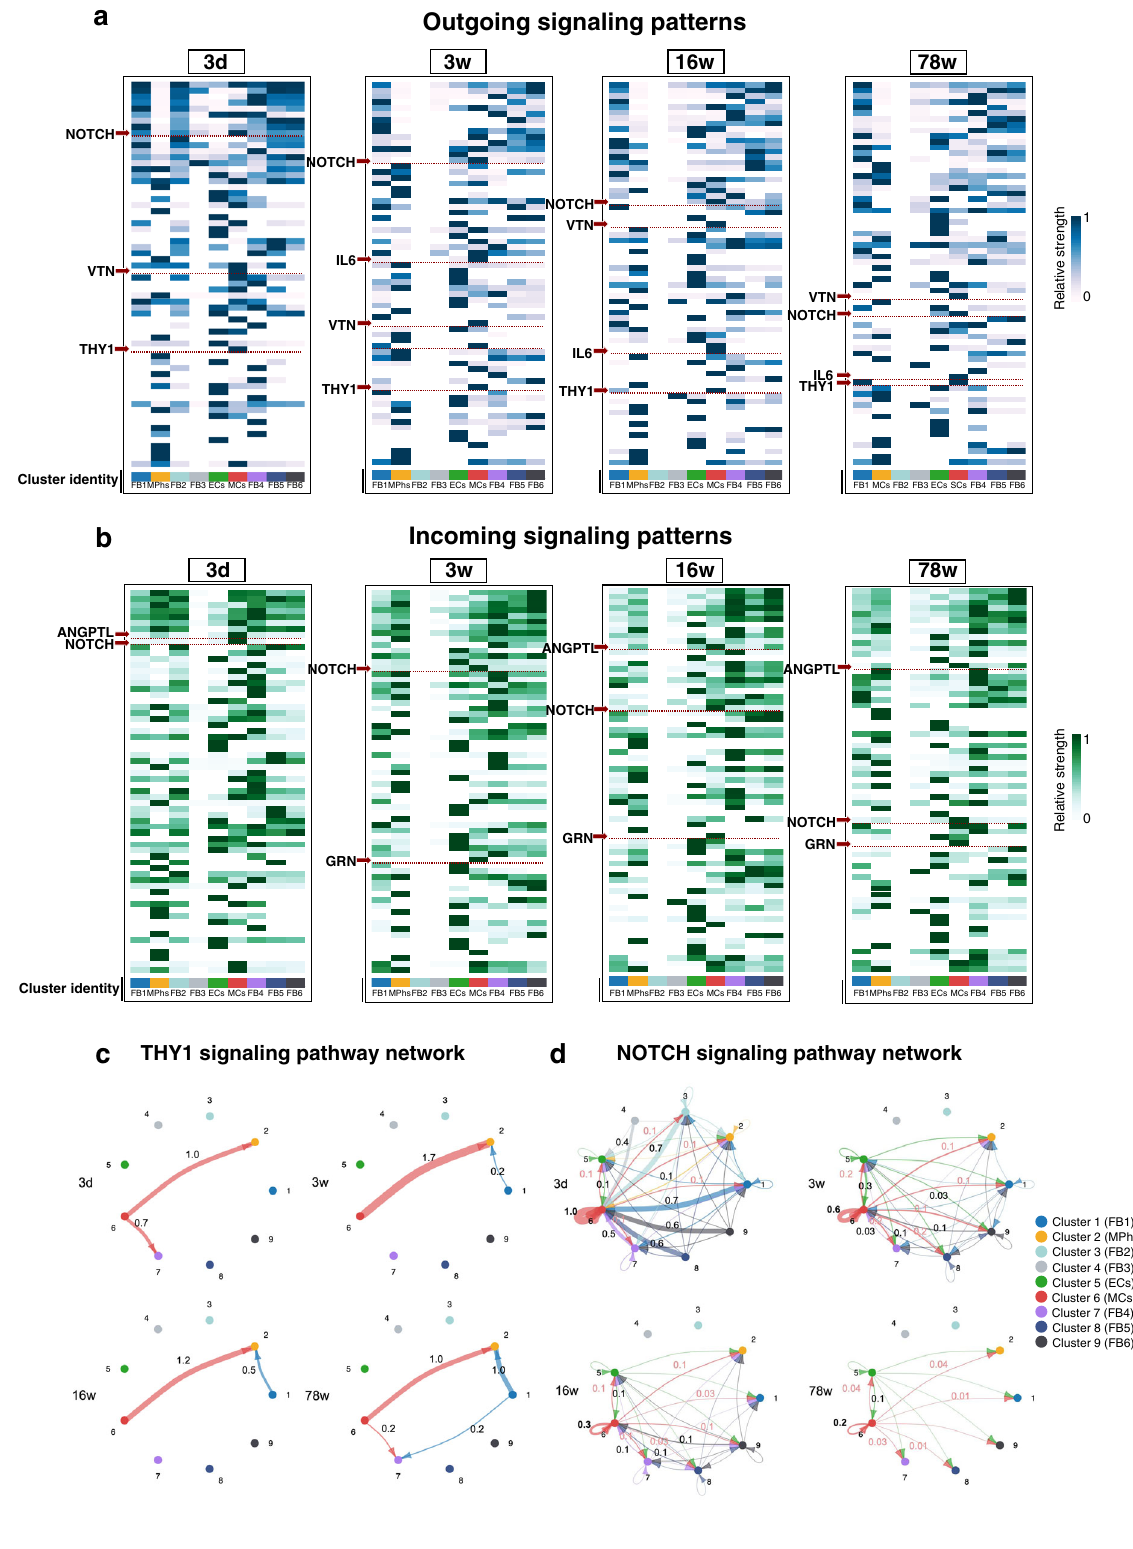
Fig. 5 | NOTCH/THY1 is activated in mural cells in the postnatal development and aging of TMJ discs. a Heatmap of active outgoing signaling pathways in different clusters. b Heatmap of active incoming signaling pathways in different clusters. The heatmap color bar in ( a ) and ( b ) represents the relative signaling strength of a signaling pathway across cell groups, determined by computing the